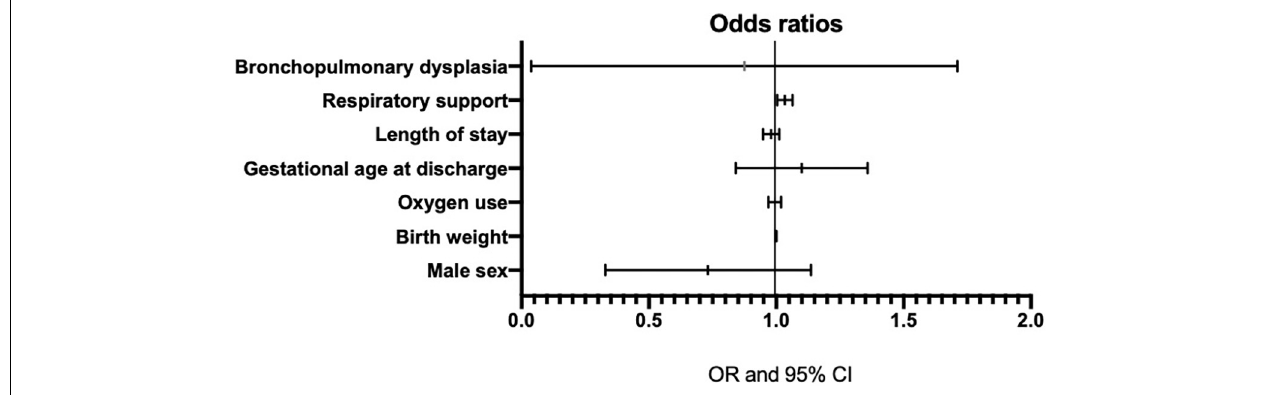
FIGURE 2 | Odds ratios with 95% confidence intervals for model covariates from the logistic regression analysis modeling late respiratory diseases.